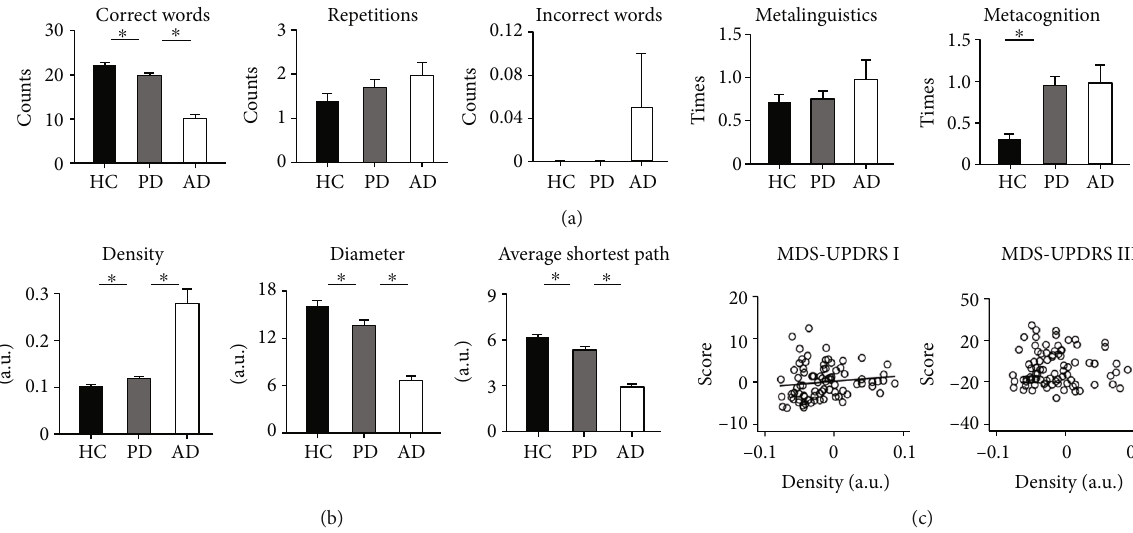
Figure 2: (a) Means and standard errors of correct words, repetitions, incorrect words, metalinguistic reference, and metacognitive reference in healthy controls (HC), patients with Parkinson ’ s disease (PD), and patients with Alzheimer ’ s disease (AD). (b) Means and standard errors of graph density, diameter, and average shortest path in each group. The asterisks ( ∗ ) indicate signi fi cant di ff erences between PD patients and two control groups in standard and graph parameters. (c) In patients with PD, the density of speech graphs was correlated with the severity of non-motor symptoms (MDS-UPDRS I score) but not the severity of motor symptoms (MDS-UPDRS III score). Values were